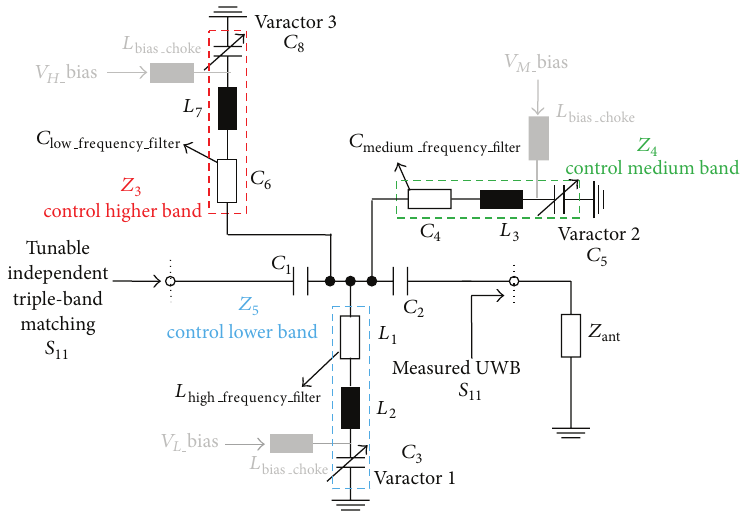
Figure 2: Proposed multiband network topology for